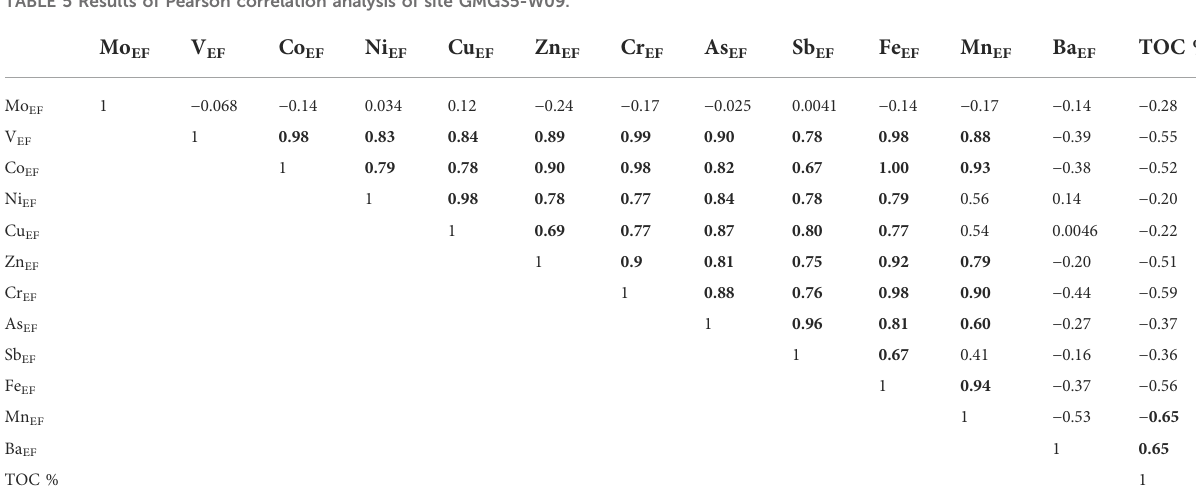
TABLE 5 Results of Pearson correlation analysis of site GMGS5-W09.